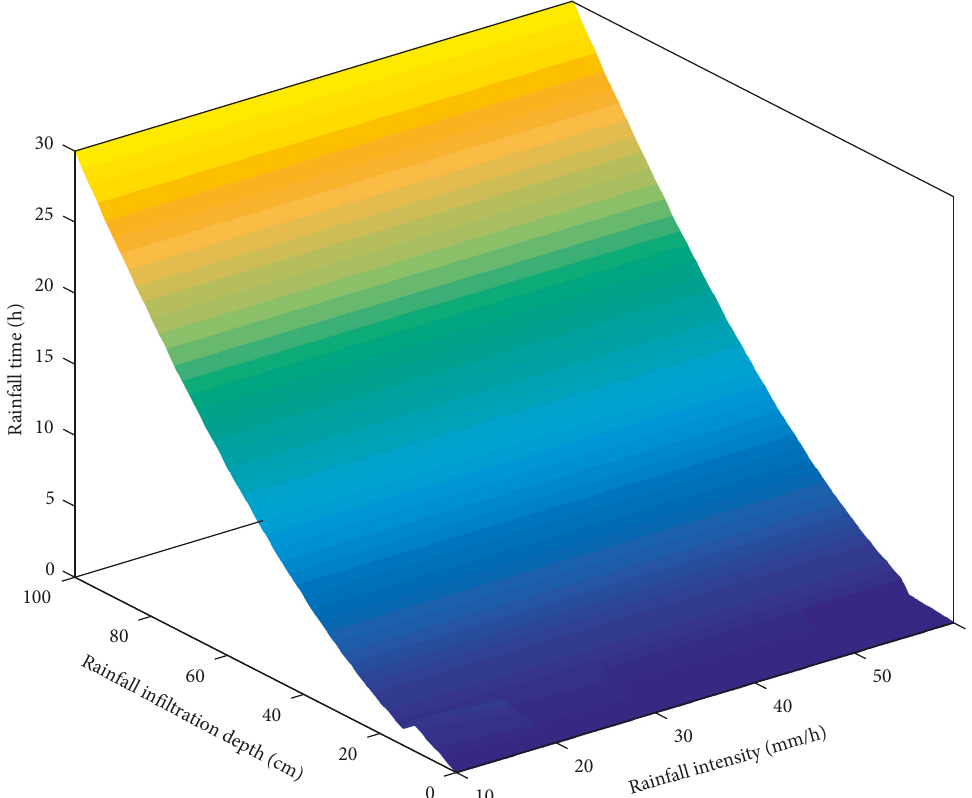
Figure 14: Variation of rainfall infiltration depth in the tailing slope with the changes of rainfall duration and rainfall